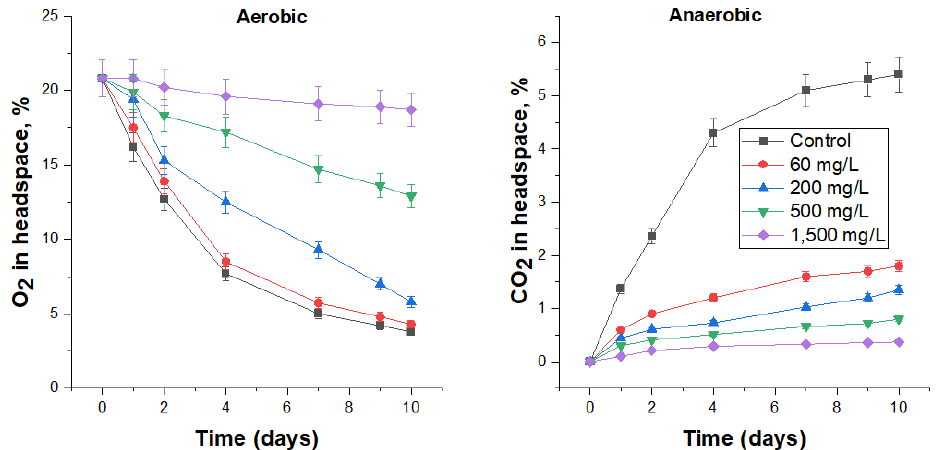
Figure 4. The effect of Sharomix on O 2 consumption under aerobic conditions and CO 2 production under anaerobic conditions by the respective microbial communities in FS.